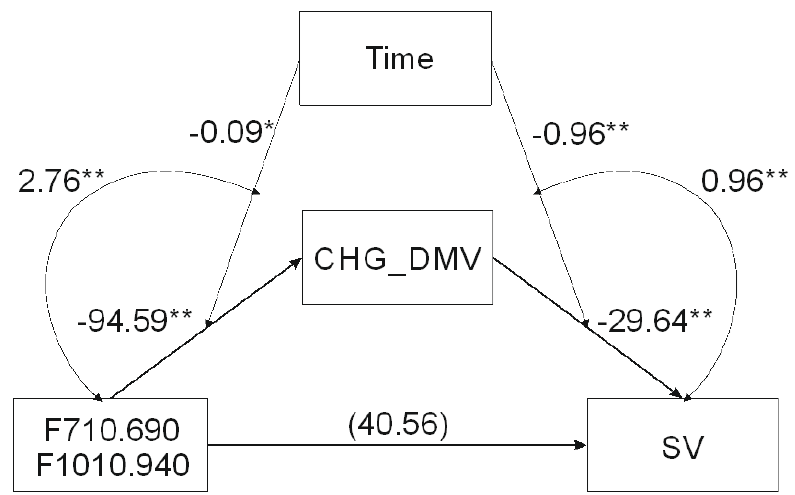
Figure 3. Mediation analysis of the compounds associated with infrared spectral regions of 710–690 and 1010–940 cm −1 to demonstrate their effect on sequence variation (SV) via demethylation of the CHG sequence context (CHG_DMV) moderated by time of tissue culture. * p < 0.05, ** p < 0.01.